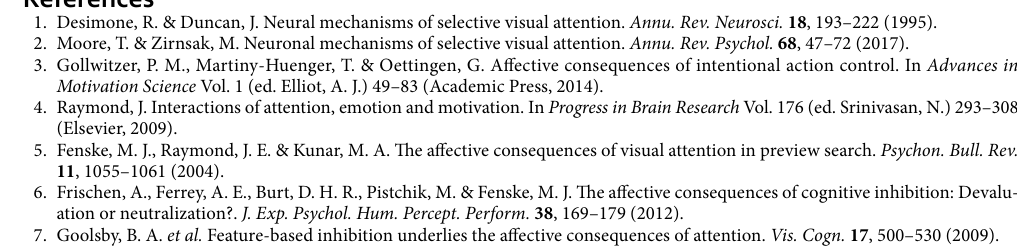
and neutral product again for 1000 ms, but with a new target product. Figure 5 illustrates the procedure of the search tasks. At the beginning of each search task, a blue fixation cross surrounded by a blue circle, placed in the middle of the screen, indicated that a target product would follow (1000 ms). Participants were then presented with a target product in the middle of the screen where the fixation cross had appeared (1000 ms). After a black fixa- tion cross in the middle of the screen (1000 ms), we presented two products simultaneously on the left or right screen side, one being the target product and the other a distractor product (1000 ms). The target was randomly presented on the left or right. On the subsequent screen participants had to indicate the side on which the target product had appeared by pressing “A” (left side) or “L” (right side) on the keyboard. The target was randomly presented on the left or right. After participants pressed the corresponding key, a black fixation cross appeared in the middle of the screen (1000 ms), before the neutral product was presented in the middle of the screen (1000 ms). We told participants that the purpose of this screen was to clear their visual memory, but, in truth, this product represented the neutral comparison alternative used in the subsequent choice phase. Finally, a separation screen appeared with the text “Please wait” to prepare participants for the next trial (1000 ms). When the side of the target was not correctly indicated, an error message (“This was wrong!”) appeared after the separation screen (1000 ms). Perceived fluency choice task. Each participant made 32 two-alternative forced choices in which the task was choosing those products which could be perceived more easily. Participants made eight choices for each of the following comparison conditions: target products compared to neutral products, target products compared to novel products, distractor products compared to neutral products, and distractor products compared to novel products. Half of the distractor products were randomly compared against a neutral product and the other half against a novel product of the same category. For the target products, from each search trial, we randomly selected one of the two products presented as target products and randomly compared half of them against neu- tral products and the other half against novel products. The procedure was the same for each trial. Following a black fixation cross in the middle of the screen (1000 ms), participants saw the two choice options for a limited time together on the screen (1000 ms). Which product was presented on the left or right side was randomized per trial. After the screen was cleared, a choice screen appeared with no time limit. The participants had to indicate the product they perceived more fluently (“Which product did you perceive more fluently?”) by pressing “A” (left product) or “L” (right product). After participants made their choice, the separation screen “Please wait” appeared before the next choice trial started (1000 ms).